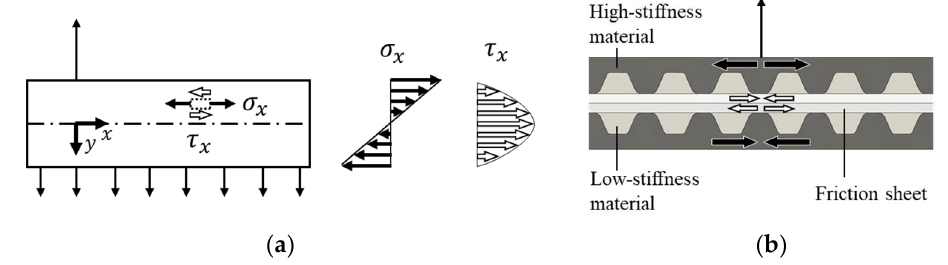
Figure 3. Stress in the device. ( a ) Normal and horizontal shear stress in the grasped device in a high-stiffness state. ( b ) The wavy-shaped beam and stress while the device is grasped and